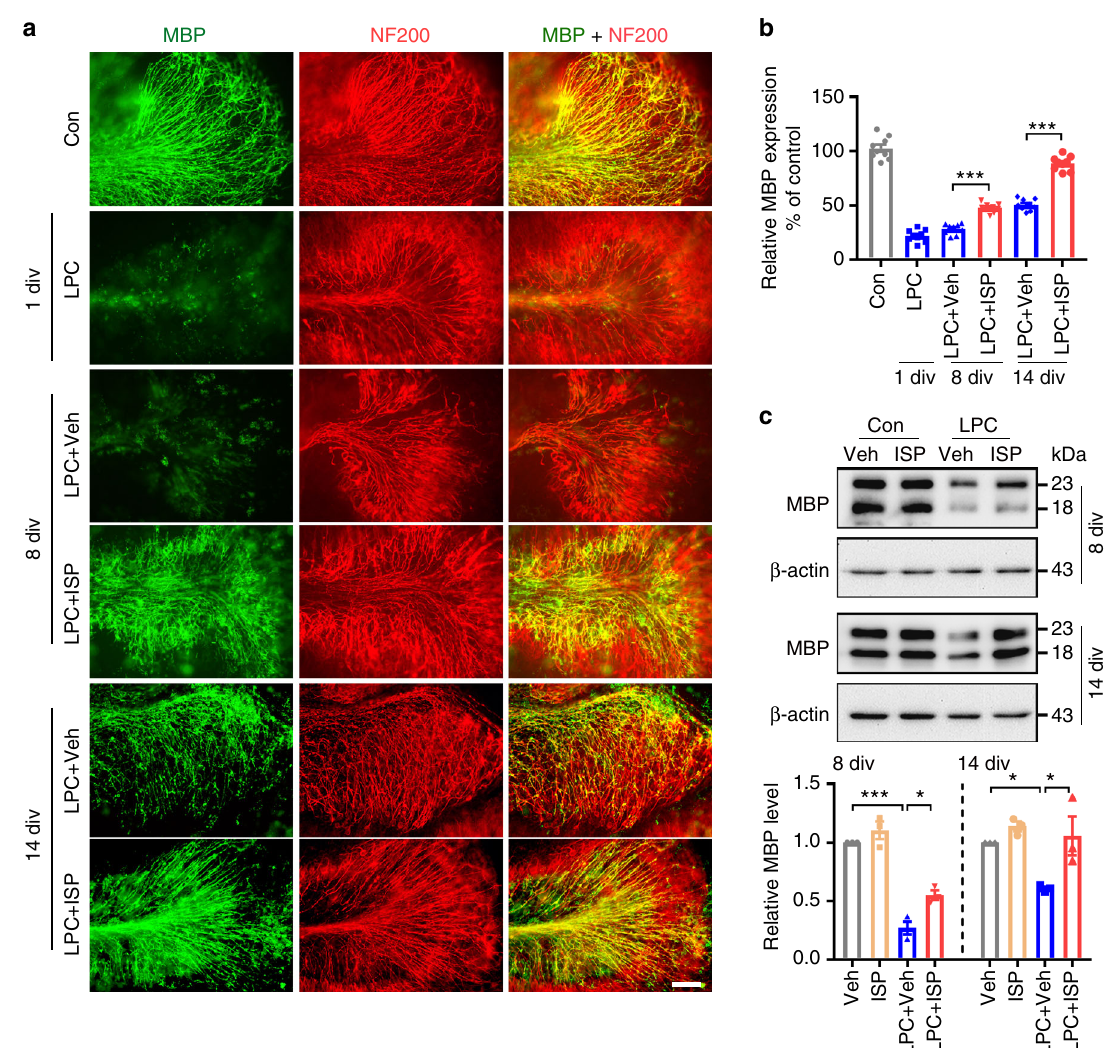
Fig. 4 ISP accelerates remyelination in LPC-treated organotypic cerebellar cultures. a Representative immunohistochemistry images of MBP and neuro fi lament-200 (NF200) show normal myelination in naive (Con) sections, LPC-induced demyelination at 1 day in vitro (div), and increased remyelination after ISP treatment in LPC-demyelinated cerebellar slices at 8 div and 14 div. Scale bar = 100 μ m. b Bar graph illustrates relative MBP immunoreactivity (i.e., colocalization of MBP and NF200) in cerebellar slices compared to no treatment (100% as control) ( n = 9 slices from 3 independent replicates per group, ANOVA F(5,48) = 230.4, Tukey ’ s multiple comparison test, 8 dpl: P LPC + Veh versus LPC + ISP < 0.0001, 14 dpl: P LPC + Veh versus β -actin LPC + ISP < 0.0001). c Western blot analysis of MBP expression in vehicle or ISP-treated cerebellar slices at 8 div and 14 div. Data are normalized to protein expression ( n = 3 independent replicates per group. 8 div: ANOVA F(3,8) = 58.89, Tukey ’ s multiple comparison test, P Veh versus LPC + Veh < 0.0001, P = 0.0187; 14 div: ANOVA F(3,8) = 6.281, Tukey ’ s multiple comparison test, P P = LPC + Veh versus LPC + ISP Veh versus LPC + Veh < 0.048, LPC + Veh versus LPC + ISP 0.025.) The data are presented as mean ± s.e.m. * P < 0.05, ** P < 0.01, *** p <